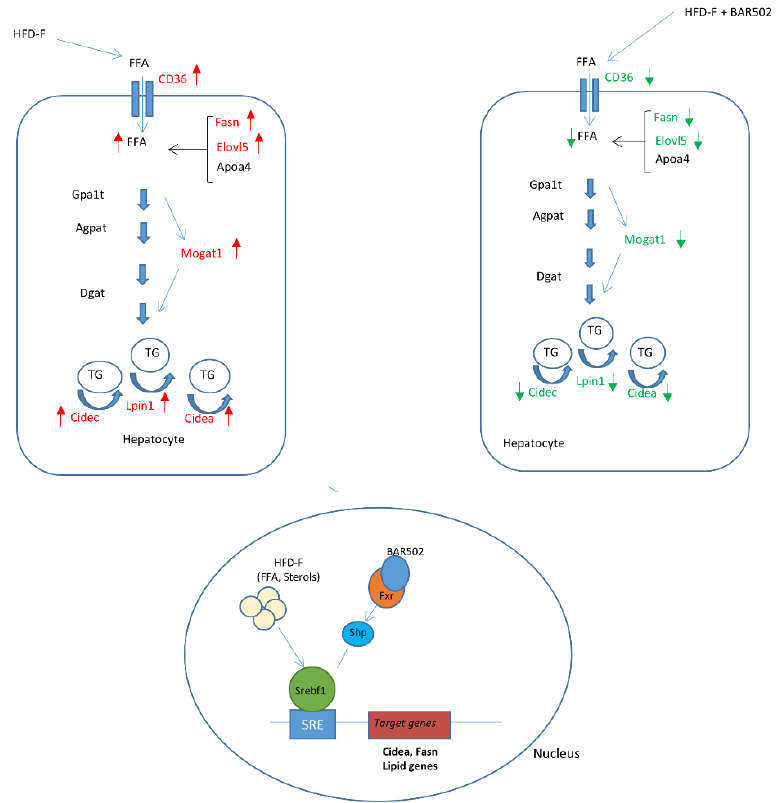
Figure 8. Schematic representation of the transcriptional regulation and role of CIDE pathway in controlling hepatic lipid metabolism (red and green arrows indicate respectively up- and down- regulated genes) Under HFD–F treatment the gene expression of protein involved in triglycerides synthesis and storage, resulted increased. Particularly the HFD–F via Srebf1 activation, promoted the transcription of lipidogenic genes, such as Fasn and Cidea. BAR502 activates FXR thus suppressing a cluster of genes downstream to Srebf1 including fatty acid synthase (Fasn) and Cell death-inducing DFF45-like e ff ector (CIDE) genes, Cidea and Cidec, involved in lipid droplets formation and triglycerides